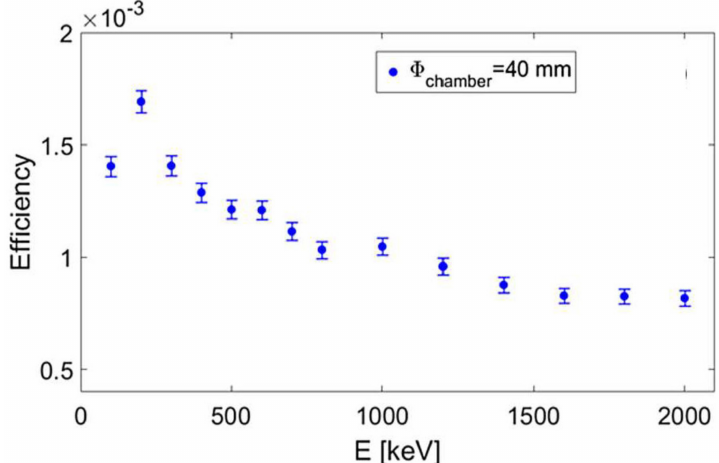
Figure 5. Trend of the detection efficiency of the HPGe array made of 14 detectors having 70% relative efficiency, as a function of the γ -rays’